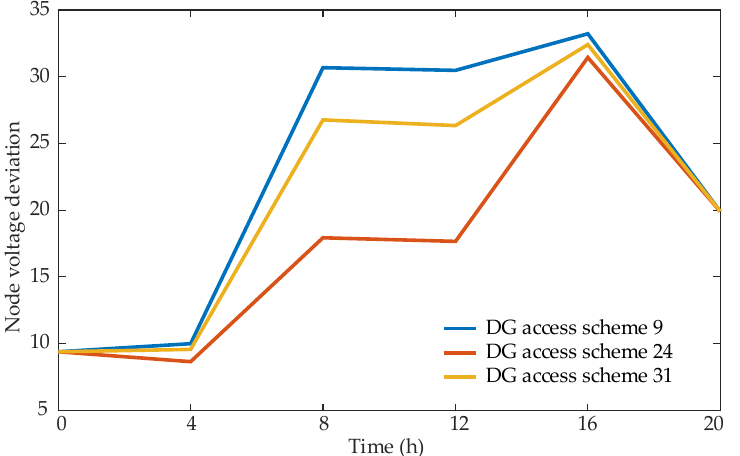
Figure 7. The node voltage deviation of schemes 9, 24 and 31 under scenario 5.